Question: Reading the figure, is the described quantity rising or falling?
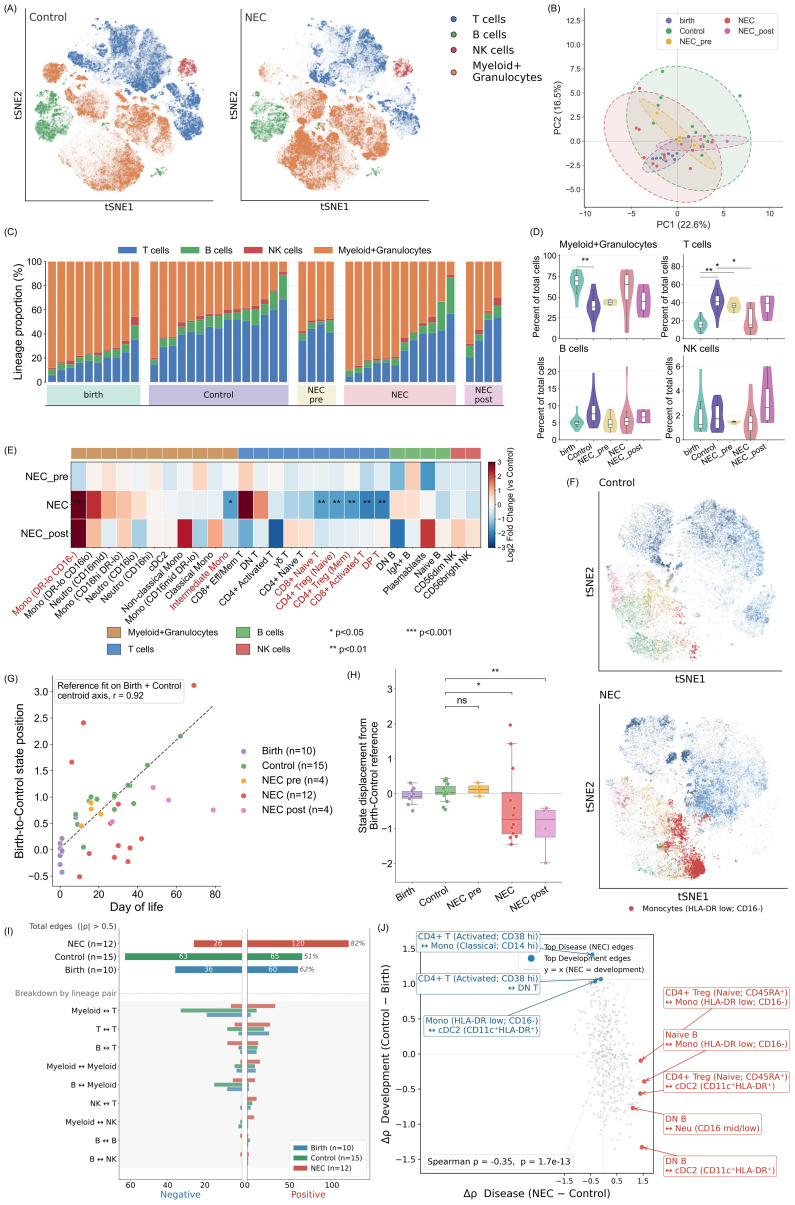
Answer: increasing